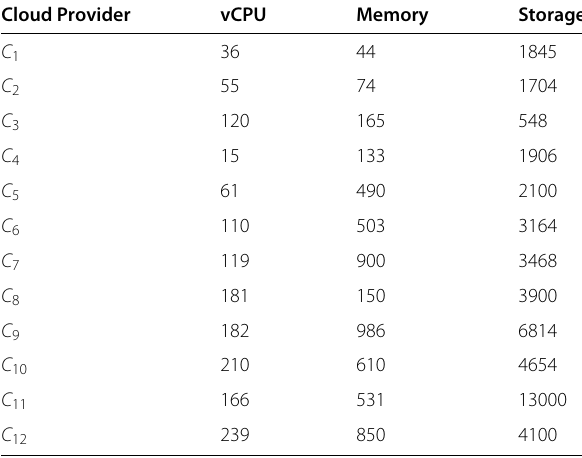
Table 1 Resource capacity of cloud providers. vCPUs are expressed in 100s of cores, memory and storage in 100 GB units Cloud Provider vCPU Memory